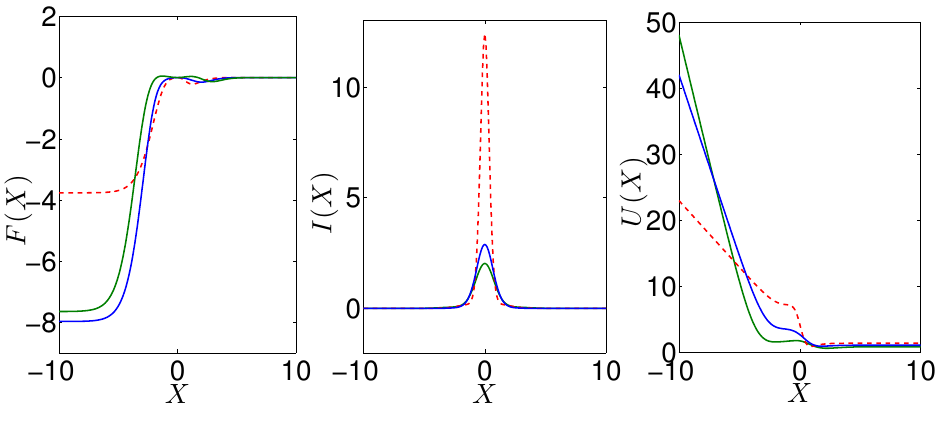
Figure 8 . Plots of the functions F ( X ) (left), I ( X ) (middle) and U ( X ) (right) as a function of the position X of the kink’s center, evaluated through the method of collective coordinates, as discussed in the text. Blue corresponds to ǫ = 1, q = 0 . 7115. Green corresponds to ǫ = 0 . 5, q = 0 . 6196. Dashed red corresponds to ǫ = 20, q = 1 .